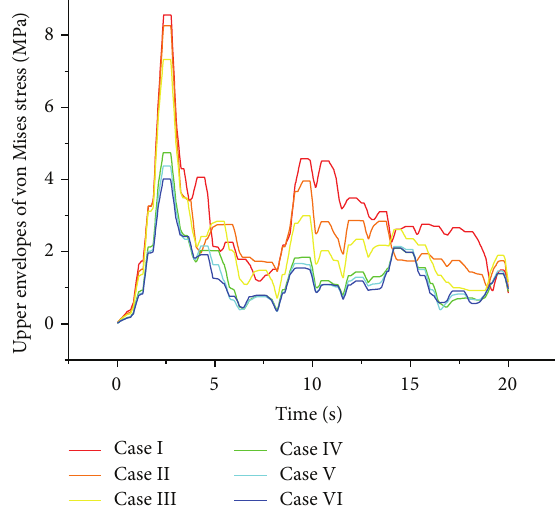
Figure 9: The upper envelopes of von Mises stress time history at Point 3.